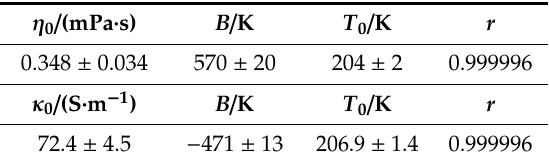
Table 1. Fitting parameters of Vogel–Fulcher–Tamman (VTF) equations applied to the viscosity and